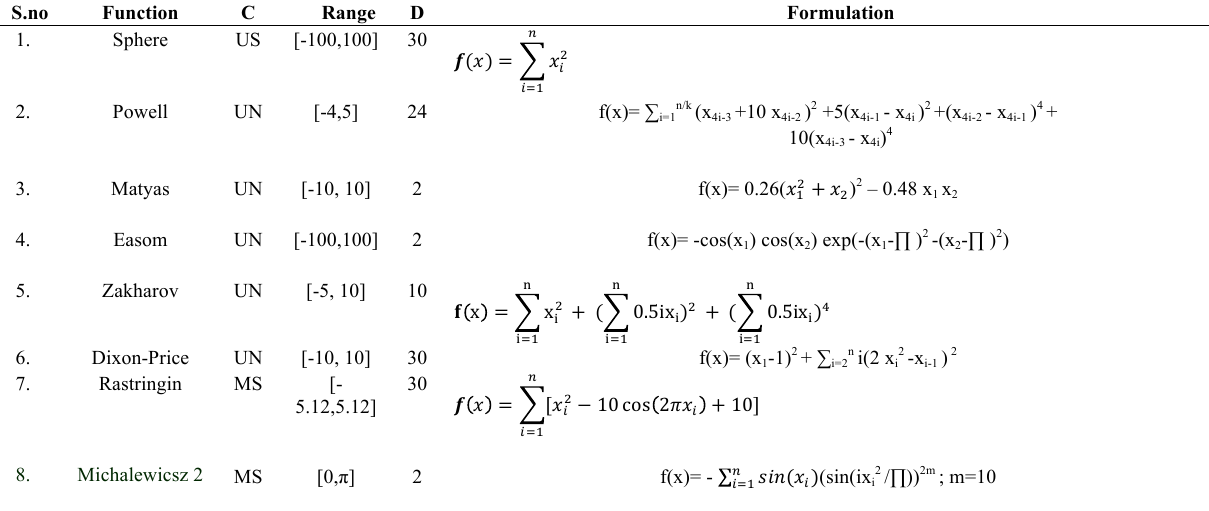
TABLE I B ENCHMARK F UNCTIONS U SED (U- UNIMODAL , M- MULTIMODAL , N- NON - SEPARABLE , S- SEPARABLE